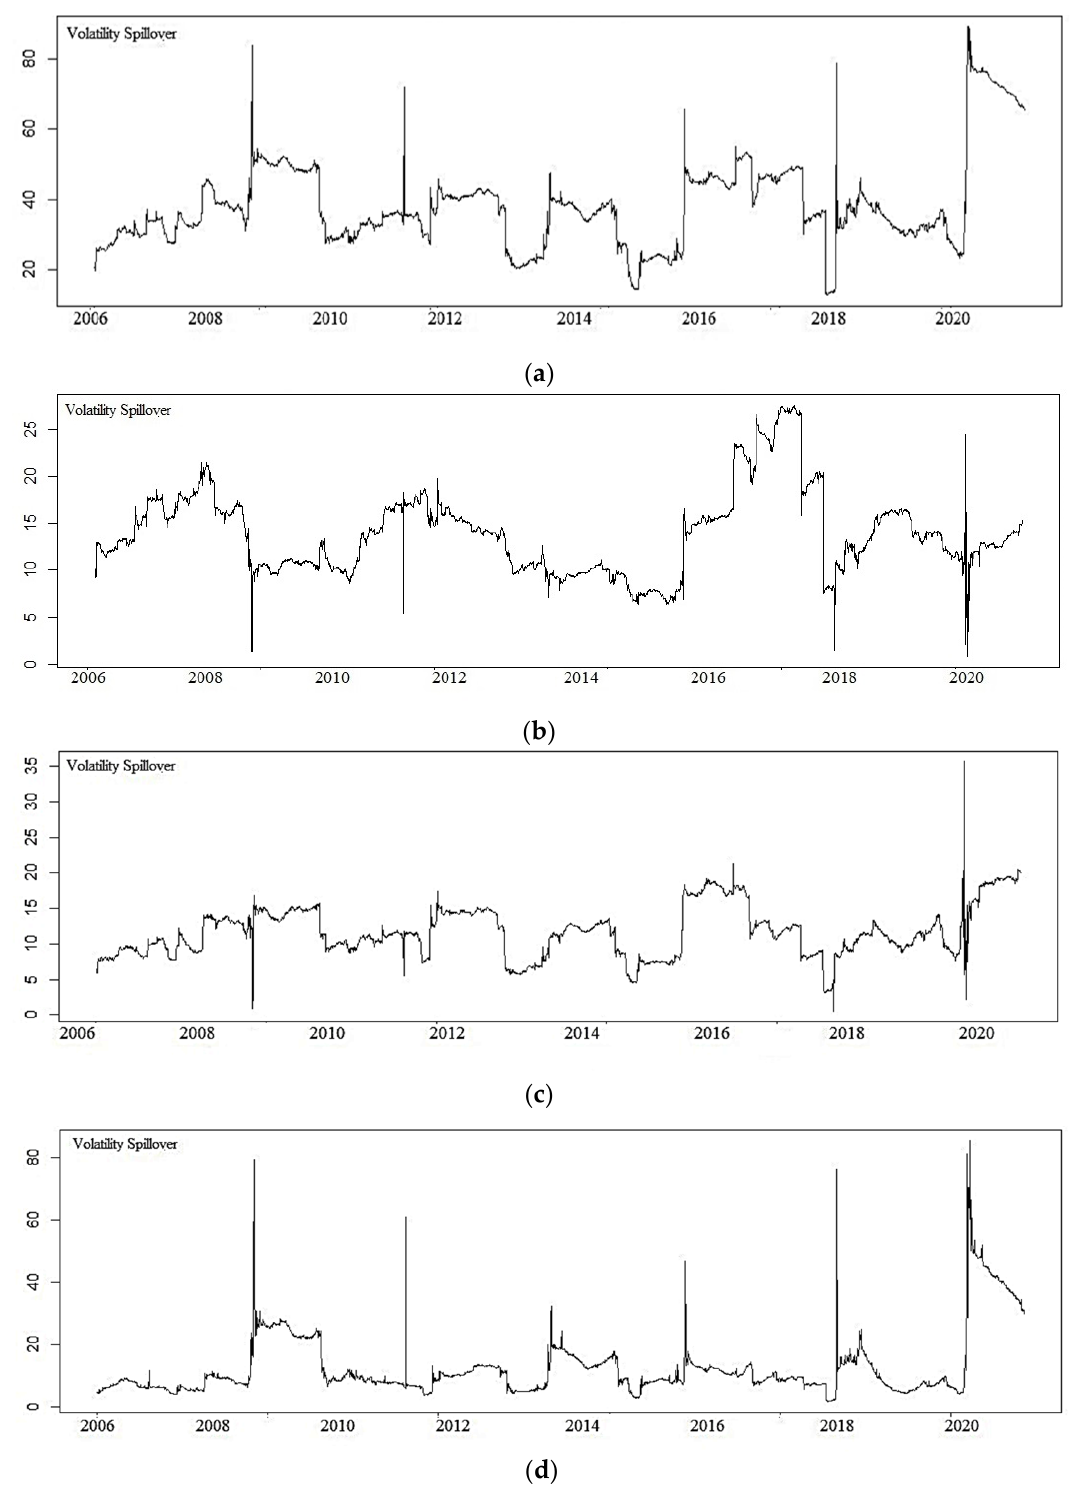
Figure 4. Volatility spillover based on the DY12 and BK18 methods: ( a ) Connectedness on asset volatility using DY12; ( b ) BK18 frequency domain for short-term (1 day to 5 days); ( c ) BK18 frequency domain for medium-term (from 6 days to 22 days); ( d ) BK18 frequency domain for long-term (22 days to infinity). The dynamic volatility connectedness is measured using a 200-day rolling window and a forecast horizon of H = 100 days.